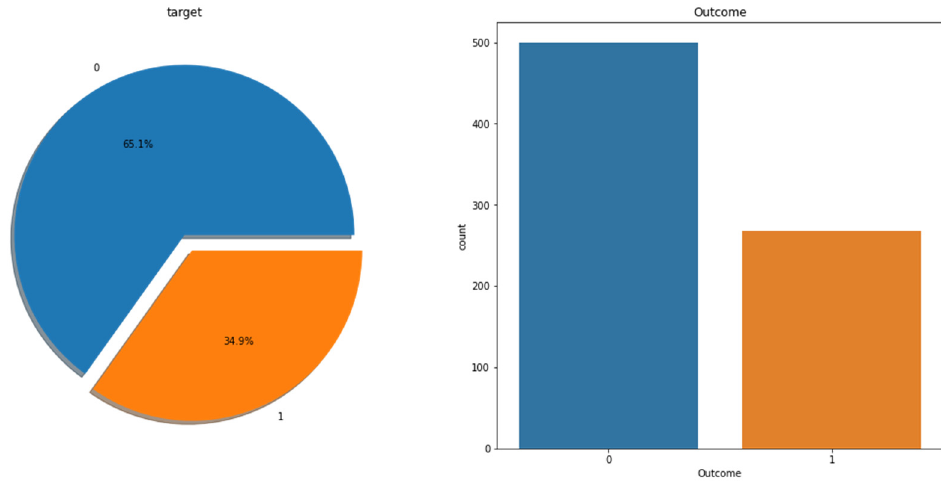
Figure 4. Correlation matrix graph of the data set. Table 2. Dataset description.